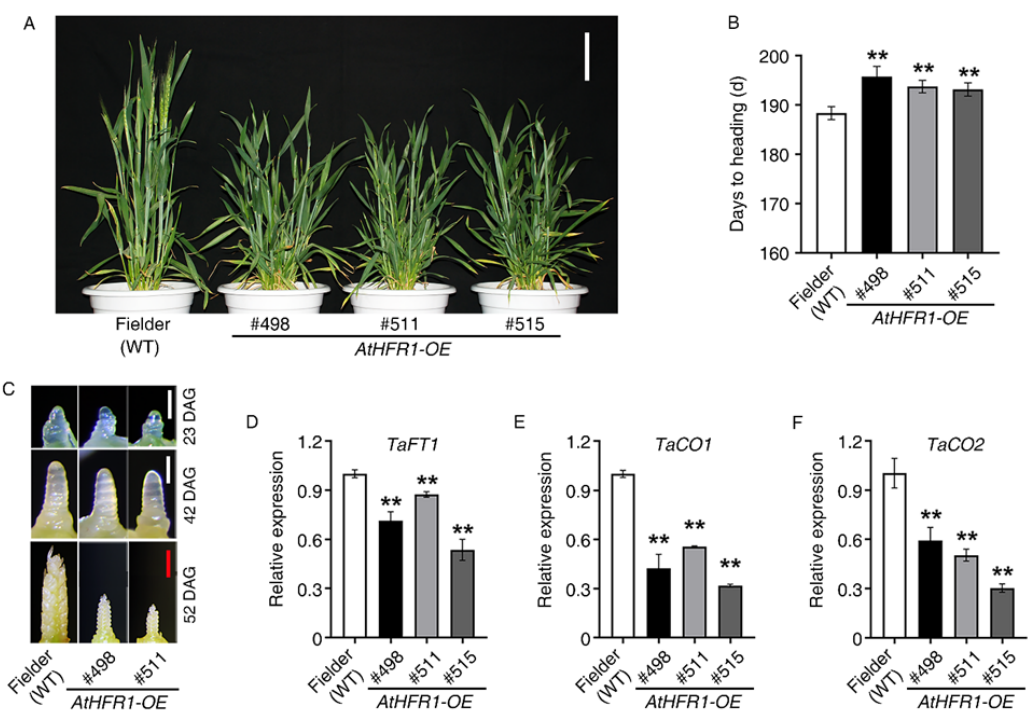
Figure 2. The AtHFR1 transgene delays heading in common wheat: ( A ) Morphology of the WT (cv. Fielder) and AtHFR1 transgenic lines (#498, #511, and #515) at heading (181 days after sowing). Bar = 10 cm. ( B ) Heading data for the WT and AtHFR1 transgenic lines (#498, #511, and #515). Emergence of the first ear from the flag leaf sheath was recognized as the heading date. Data are means ± SDs, n ≥ 25. ( C ) Development of the main shoot apex of the WT and AtHFR1 transgenic lines (#498 and #511). Seedlings were grown under long-day conditions (14 h light/10 h dark; W light 100 μmol·m −2 ·s −1 , 22 °C) until 23, 42, or 52 DAG (days after germination). White bars = 0.25 mm, red bar = 1 mm. Real-time RT-PCR analysis of TaFT ( D ), TaCO1 ( E ), and TaCO2 ( F ) in the WT and AtHFR1 transgenic lines (#498 and #511). Flag leaves were collected at the jointing stage (148 days after sowing). Column shows the mean expression relative to TaActin for three biological replicates. Asterisks denote significant differences in #498, #511, or #515 with the WT according to one-way ANOVA (** p <